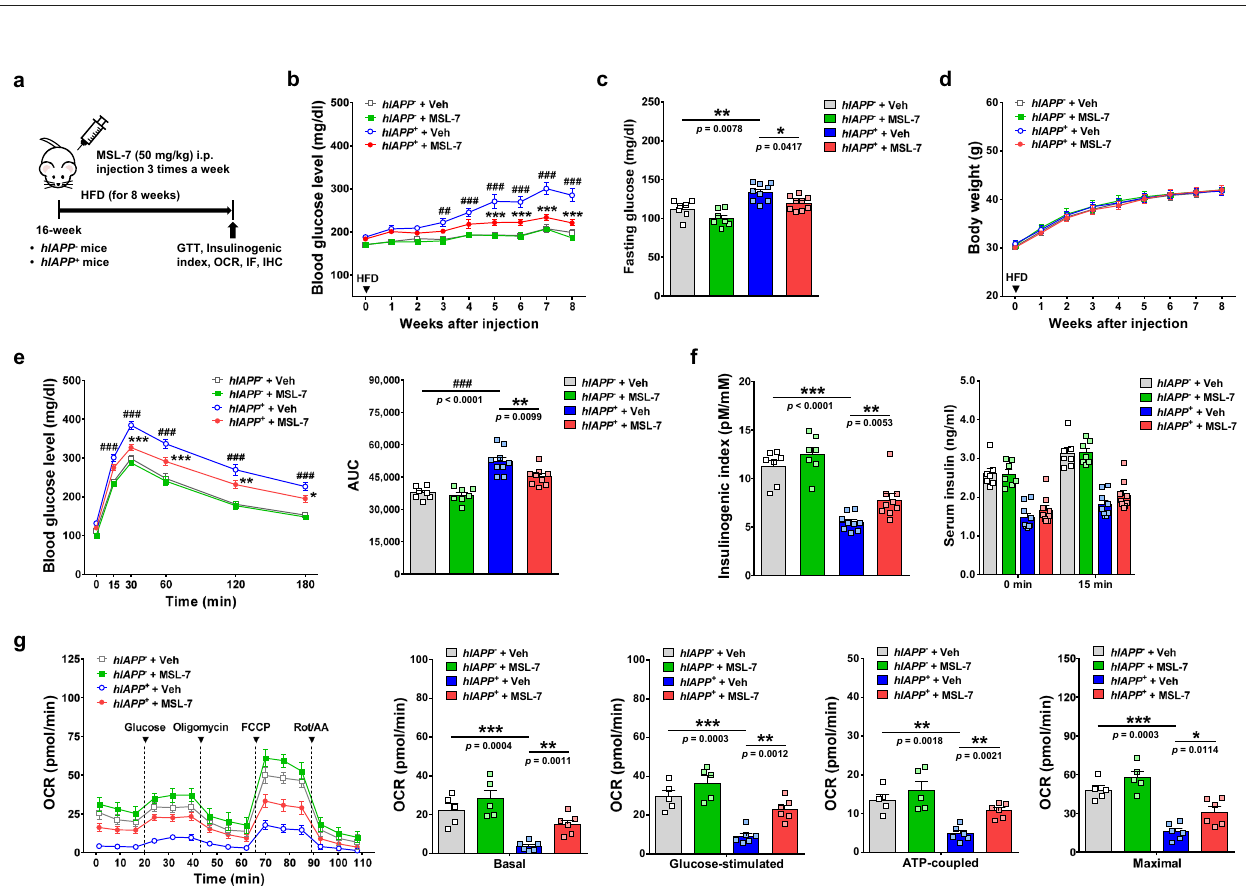
Fig. 4 Reduced MSL-7 effects in Tfeb- KO or Tfe3 -KO cells in vitro. a Tfeb -KO or Tfe3 -KO INS-1 cells were treated with MSL-7 for 4 h, and immunostained using anti-TFEB (left) or anti-TFE3 antibody (right). After DAPI staining, cells were subjected to confocal microscopy. b Tfeb -KO or Tfe3 -KO INS-1 cells transfected with mRFP-GFP-LC3 tandem construct were treated with MSL-7 for 16 h, and the numbers of autophagosome and autophagolysosome were counted ( F = 178.7, df treatment = 5, df residual = 114) (right). Representative pictures are presented (left). Inset images were magni fi ed to show red (autophagolysosomes), green, and yellow (autophagosomes) puncta. c Tfeb -KO or Tfe3 -KO INS-1 cells transfected with prepro-mIAPP-HA or prepro-hIAPP- HA were treated with MSL-7 for 16 h. Immunoblot analysis was conducted ( F = 32.9, df treatment = 5, df residual = 12) (left). Densitometric value of HA bands normalized to the respective vehicle-treated cells ( − ) are presented (right). d Tfeb -KO (left) or Tfe3 -KO (right) INS-1 cells transfected with prepro- mIAPP-HA or prepro-hIAPP-HA were treated with MSL-7 for 16 h without 3-MA, and apoptosis was measured ( F = 5.8, df treatment = 11, df residual = 36 in left panel; F = 11.3, df treatment = 11, df residual = 36 in right panel). e Tfeb -KO or Tfe3 -KO INS-1 cells transfected with prepro-mIAPP-HA or prepro-hIAPP- HA were treated with MSL-7 for 16 h in the presence of 3-MA, and apoptosis was measured ( F = 24.1, df treatment = 11, df residual = 36). All data in this fi gure are the means± SEM from more than 3 independent experiments performed in triplicate. (scale bar, 5 μ m) * P < 0.05; ** P < 0.01; *** P < 0.001 by one- way ANOVA with Tukey ’ s test. (n.s. not signi fi cant) Source data are provided as a Source Data fi le.